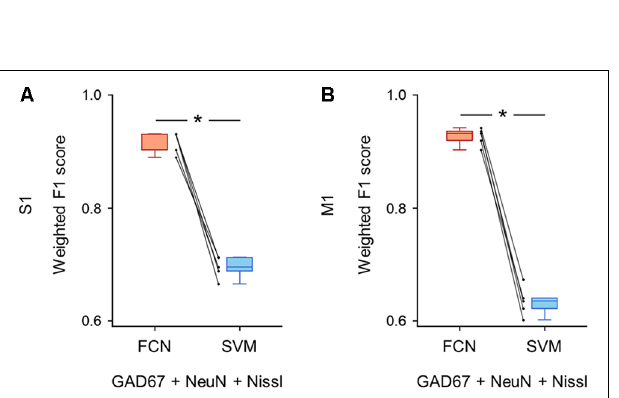
FIGURE 6 | Classification performance of cell images using both anti-NeuN and Nissl fluorescence signals. (A) Weighted F1 score of the FCN model (red) and the PCA-SVM classifier (blue) trained on cell images from S1. Two fluorescent signals (i.e., anti-NeuN and Nissl) were used for training. Each point (gray) signifies the score for the cross-validation (5-fold). P = 3.0 × 10 –4 , t (4) = 11.7, n = 5-fold cross-validations, paired t -test. * P < 0.05. (B) The same as (A) , but for M1. P = 1.9 × 10 –4 , t (4) = 13.2, n = 5-fold cross-validations, paired t -test. * P < 0.05. Abbreviations: S1, primary somatosensory cortex; M1, primary motor cortex; FCN, fully convolutional network; SVM,